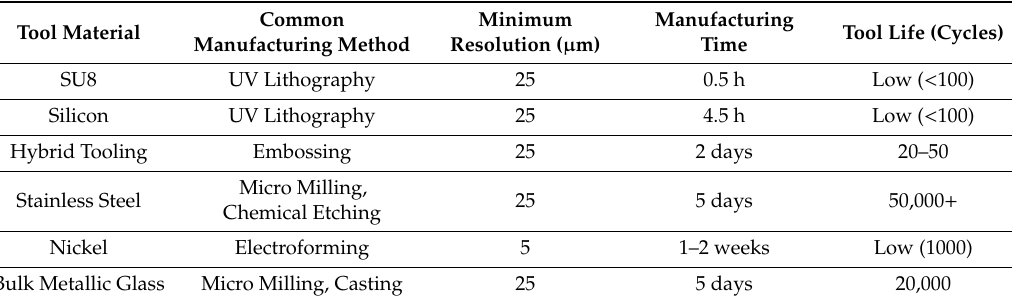
Table 2. Comparison of technologies for the manufacturing of micro-structured injection molds (adapted from